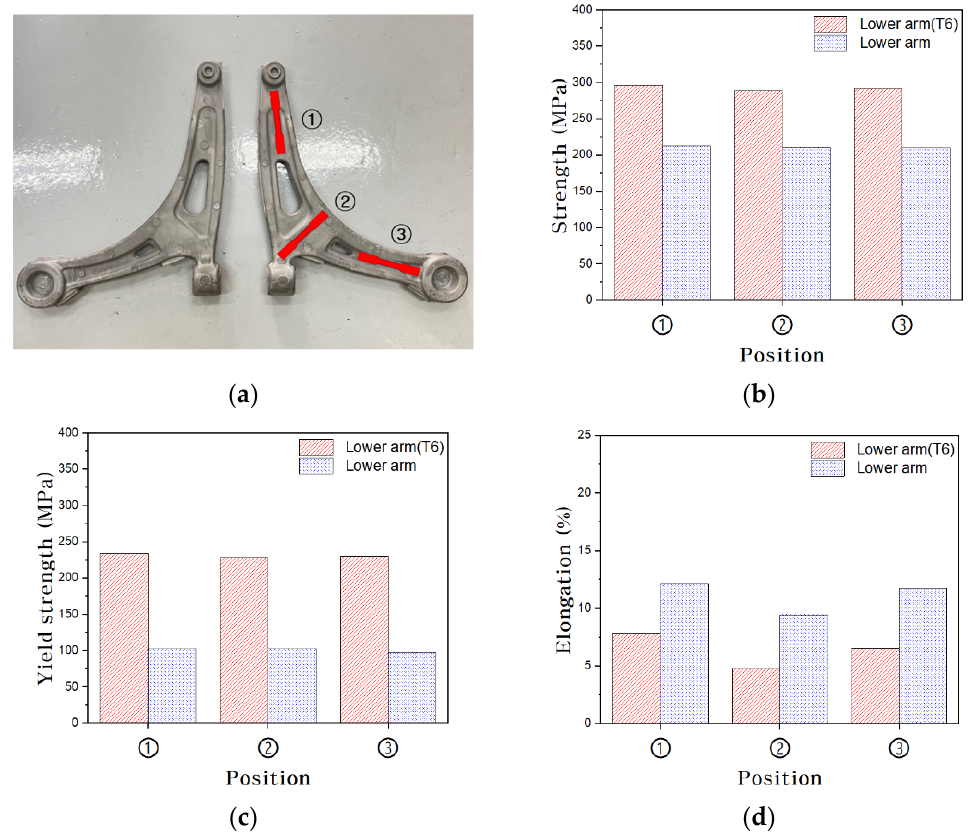
Figure 10. Mechanical properties of two-cavity lower arm at each position: ( a ) lower arm, ( b ) ultimate tensile strength, ( c ) yield strength, and ( d ) elongation.